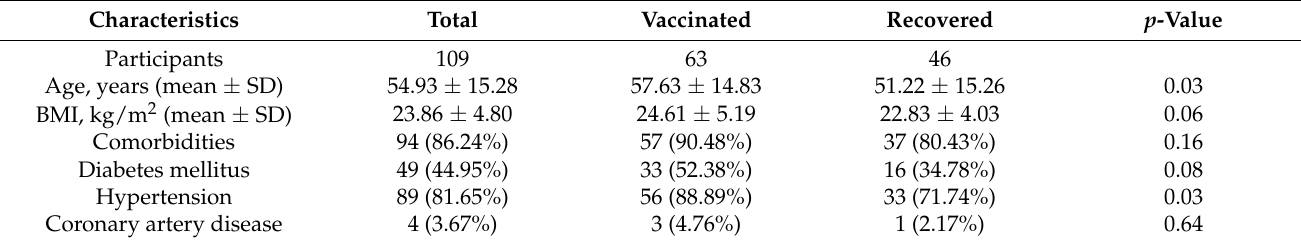
Table 1. Demographic data of participants ( n =